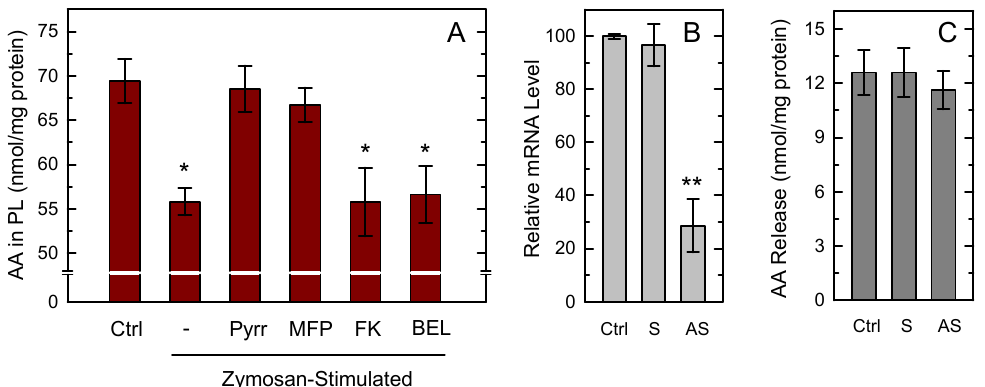
Figure 2 . AA mobilization from macrophages. ( A ) The cells were either unstimulated (Ctrl) or stimulated with 1 mg/mL zymosan for 1 h in the absence (-) or presence of the following inhibitors: 1 µM pyrrophenone (Pyrr), 10 µM methyl arachidonyl fluorophosphonate (MFP), 10 µM FKGK18 (FK), or 10 µM bromoenol lactone (BEL). Afterward, total content of AA in phospholipids was measured by GC/MS. Results are shown as means ± standard error of the mean (n=6). * p < 0.05, significance of stimulated cells versus control cells. ( B ) The cells were treated for 36 h with sense (S) or antisense (AS) oligonucleotide, or vehicle (Ctrl), and iPLA 2 β mRNA levels were determined by quantitative PCR. ( C ) After the treatments, the cells were stimulated with zymosan, and AA release was determined by GC/MS. The fatty acid release was calculated by subtracting the amount of phospholipid-bound AA in unstimulated cells from that in stimulated cells. Results, given as nmol AA per mg of total cell protein, are shown as mean values ± standard error of the mean. (n = 4). ** p < 0.01, significantly different from control